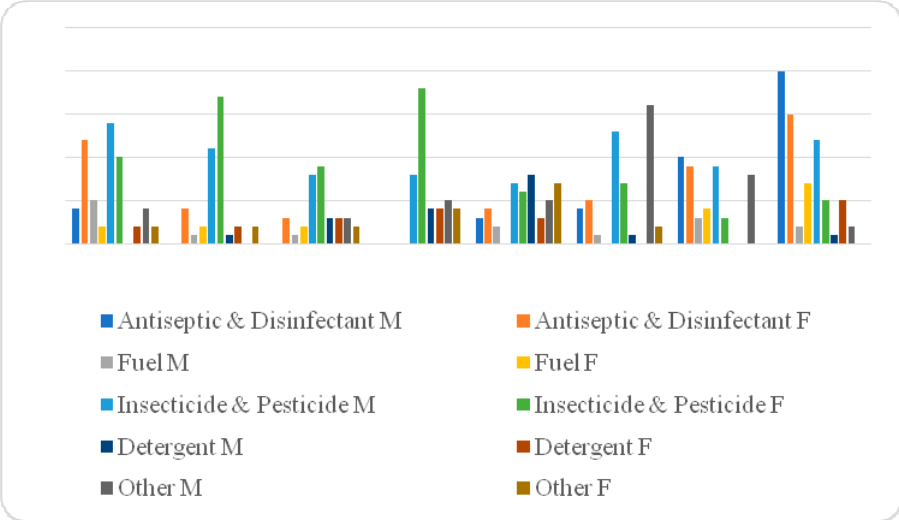
Figure 3. Frequency of poisonings and the type of poison ingested according to gender and period of poisoning.